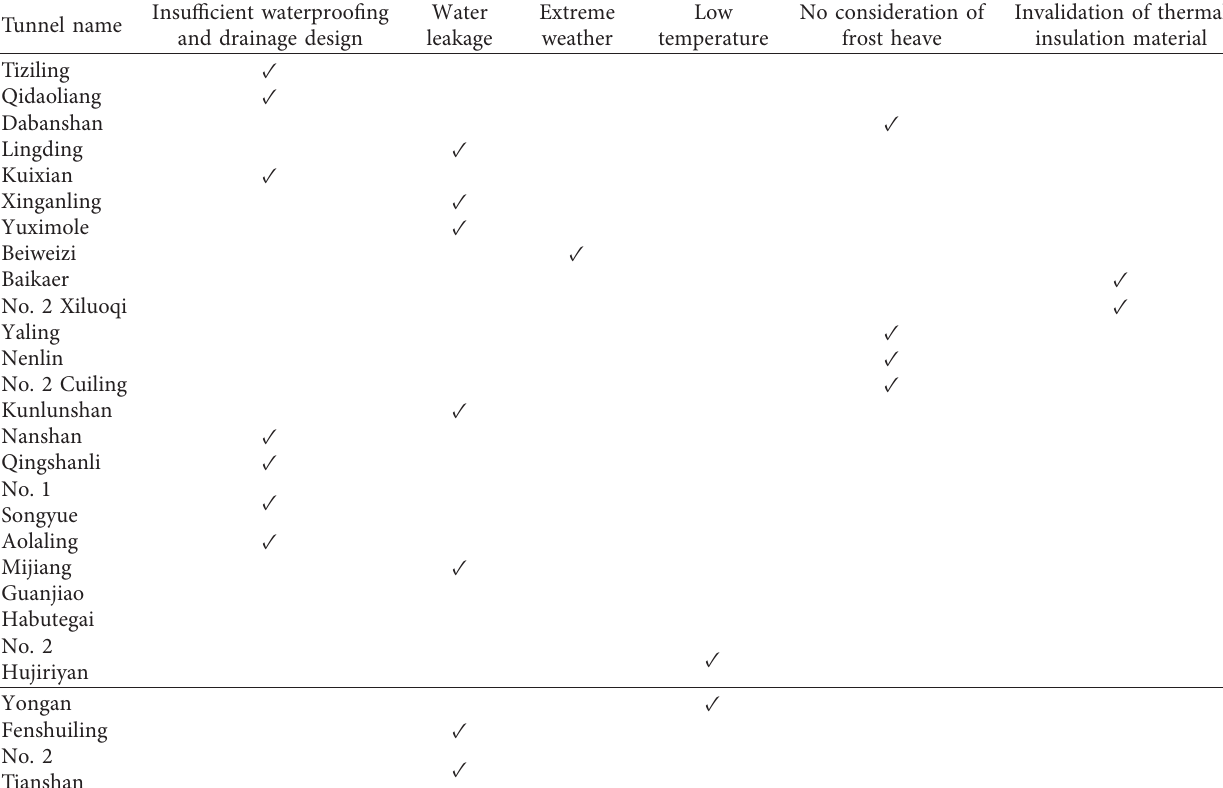
Table 2: Causes of tunnel frost damage